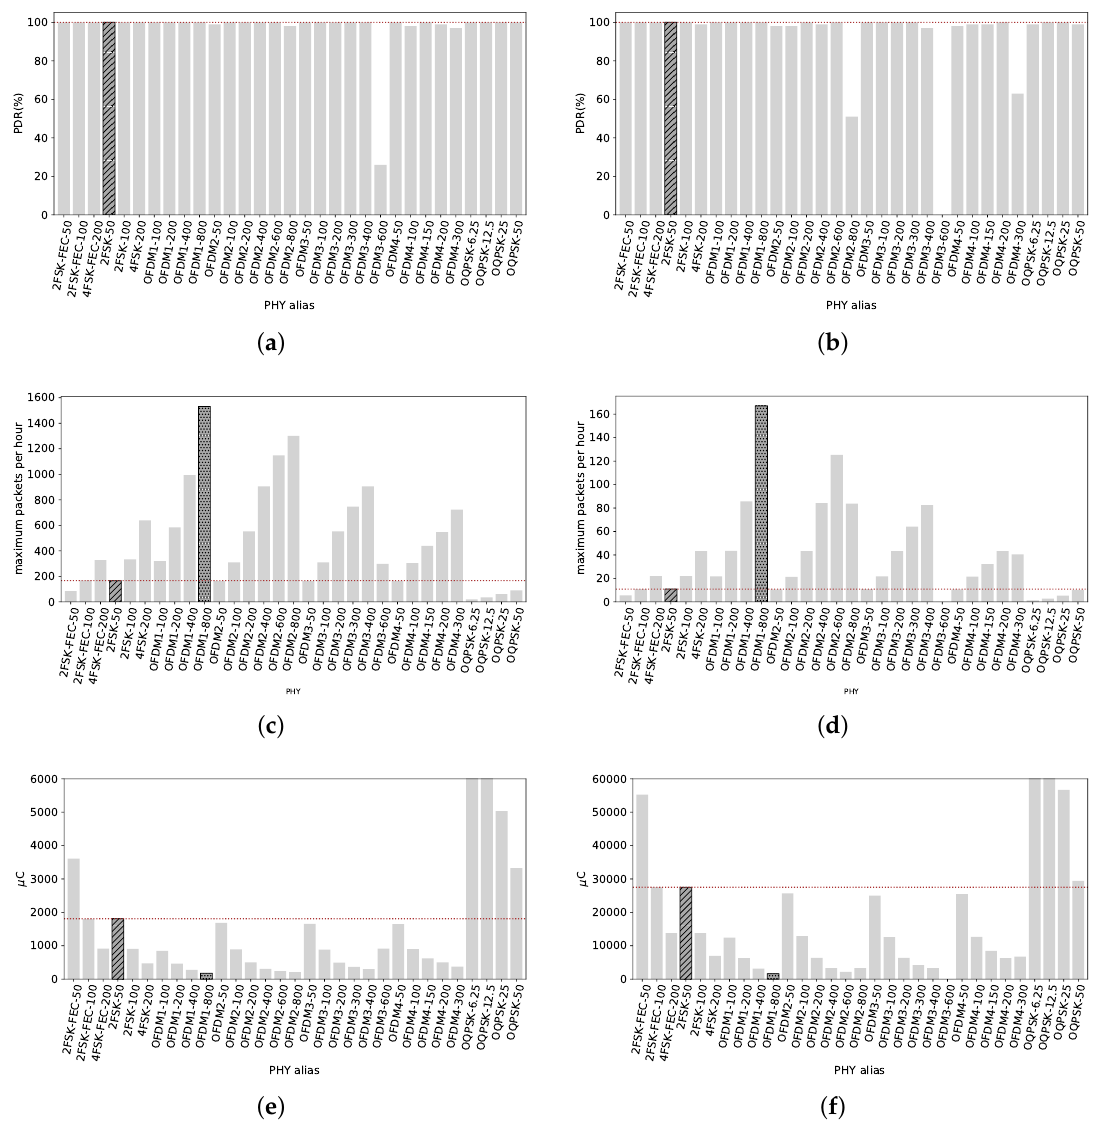
Figure 7. Line of Sight, 420 m. The radio link allows the transmission of packets with 2047 B even with the highest data rates available with a PDR very close to 100%. Within this distance, high data rates radio settings maintain high reliability while consuming less electric charge and allowing more data exchange than low data rates radio settings. ( a ) PDR of all radio settings at 420 m from TX with packets of 127 B. Except for OFDM3-600, all radio settings have a PDR close to 100%; ( b ) PDR of all radio settings at 420 m from TX with packets of 2047 B. OFDM2-800 and OFDM4-300 do not have PDR values close to 100%. OFDM3-600 has 0% PDR; ( c ) Maximum amount of 127 B packets that can be correctly sent per PHY under 0.1% duty cycle regulation. OFDM1-800 can send 1531 packets while 2FSK-50 only 166; ( d ) Maximum amount of 2047 B packets that can be correctly sent per PHY under 0.1% duty cycle regulation. OFDM1-800 can send 167 packets while 2FSK-50 roughly 11; ( e ) Average electric charge consumption per packet of 127 B correctly sent. OFDM1-800 is the most electric charge-efficient, consumes 178.6 µ C whereas the reference 2FSK-50 consumes 1807 µ C; ( f ) Average electric charge consumption per packet of 2047 B correctly sent. OFDM1-800 consumes the lowest amount of electric charge per packet, with 1637 µ C whereas the reference 2FSK-50 consumes 27.5